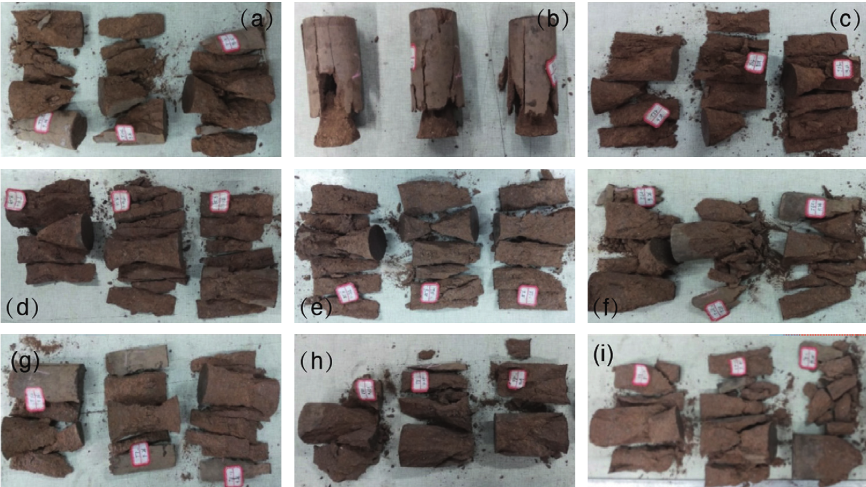
Figure 7: Pictures of geopolymer samples after uniaxial compression tests. Each row has the same M 2: 3 from the first to the third row, respectively. Each column has the same M column to the third column, respectively. M liquid / M solid ratios of each raw vary among 0.14, 0.16, and 0.18. The NaOH concentrations of each row vary among 8, 10, and 12. The details of the M liquid / M solid ratios and NaOH concentration can refer to Table